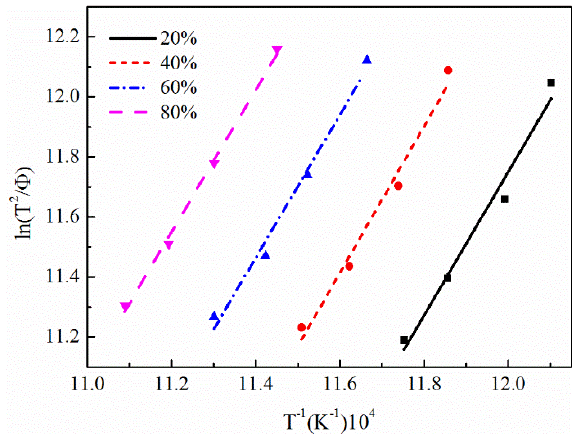
Figure 4. The KAS plot of 10,000/ T ~ ln ( T 2 /Ф ) at different phase transformed fraction of Al 0.25 CoCrFeNi high-entropy alloy.